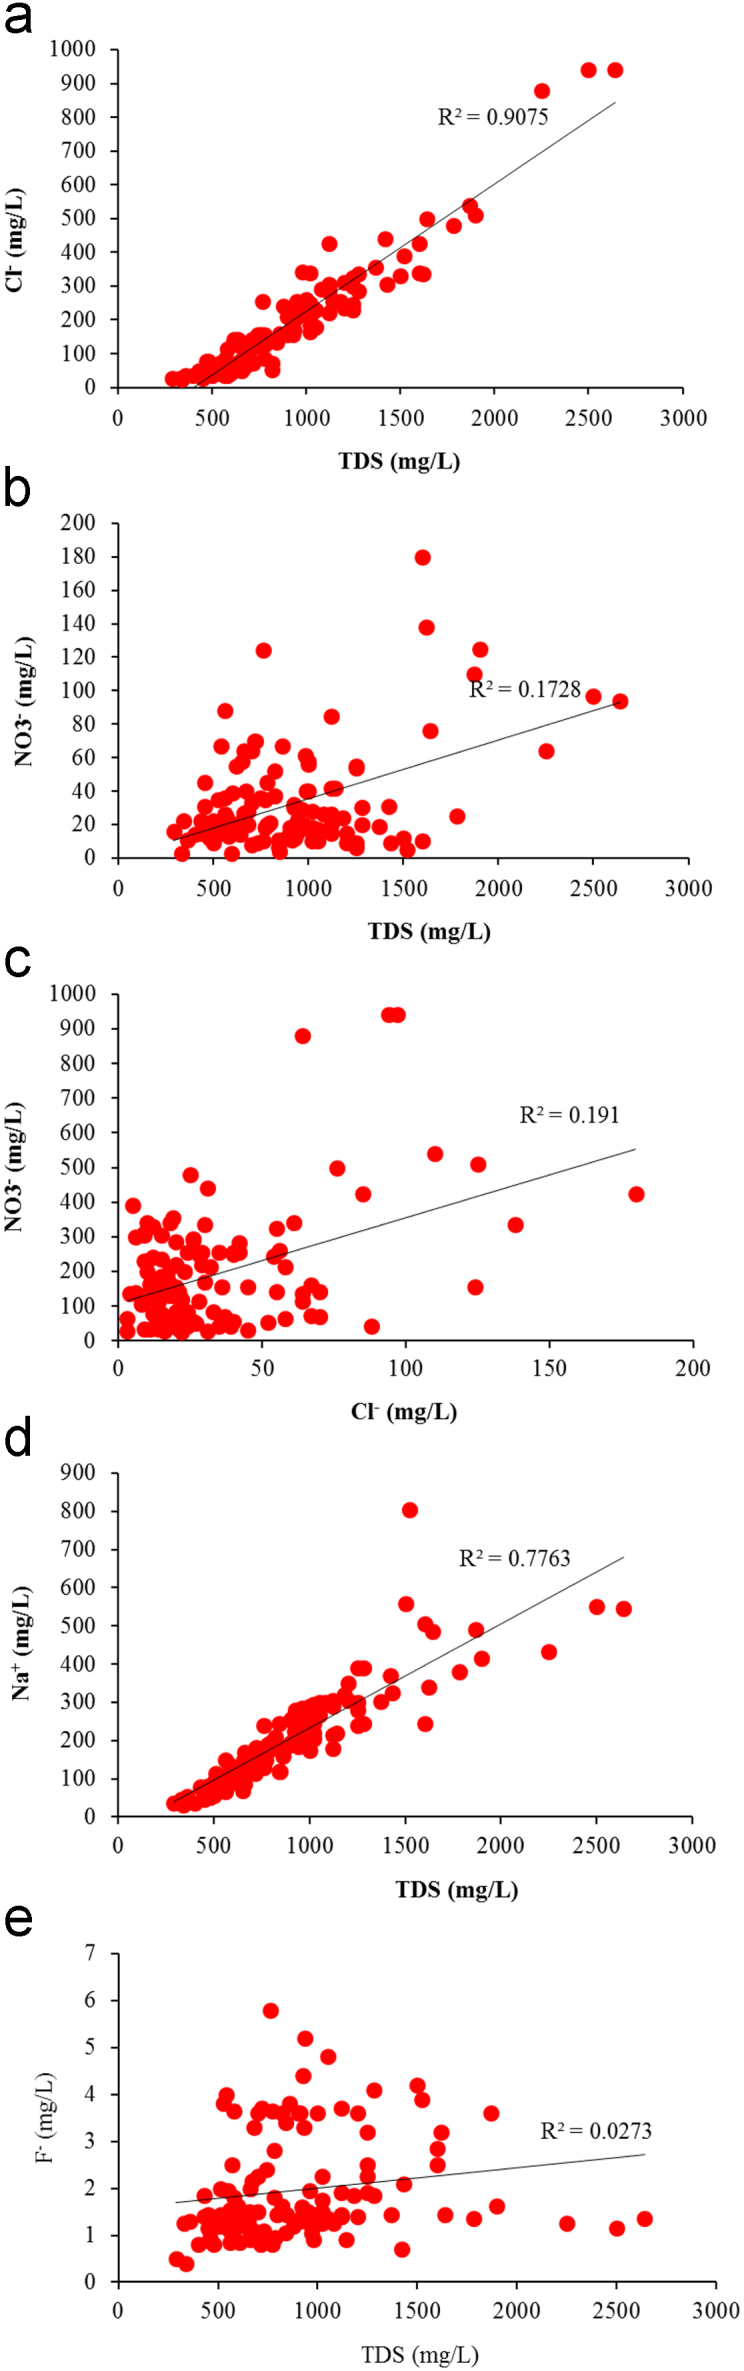
Cross plots (a) TDS vs Cl−, (b) TDS vs NO3−, (c) Cl− vs NO3−, (d) TDS vs Na+, and (e) TDS vs F− (TDS, Cl−, NO3−, Na+, F− are expressed in mg/L).